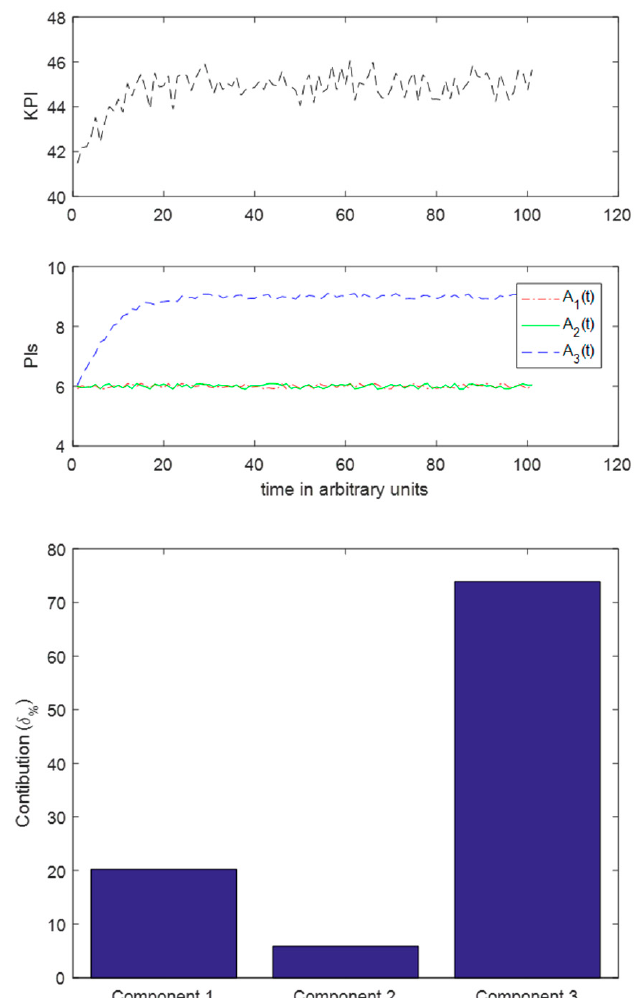
Figure 10. Case II. Top: Evolution of KPI, Middle: Evolution of PIs, Bottom, Contribution of each PI.